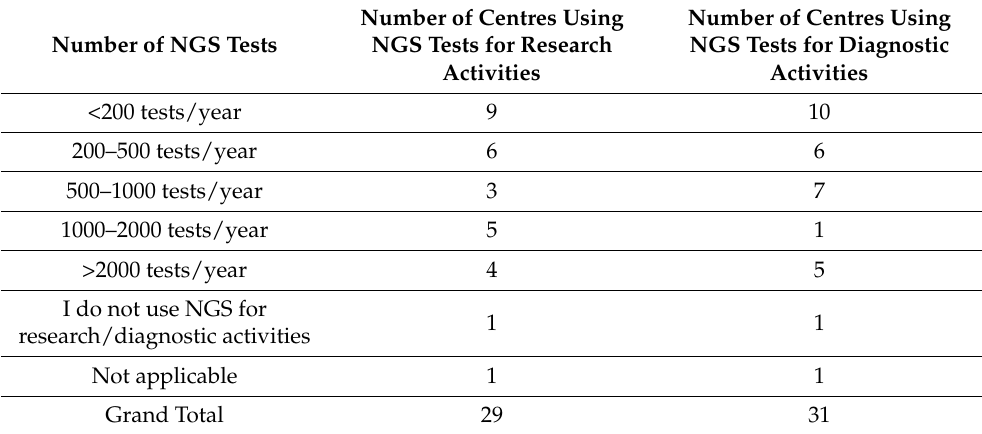
Figure 6. Number of NGS tests used for research activities in different global centres.